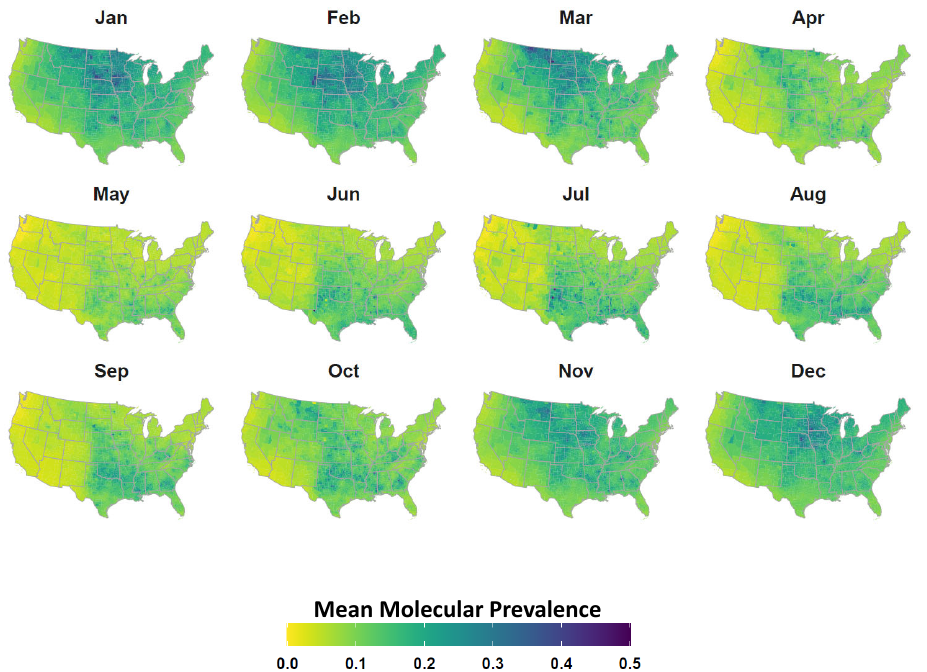
Figure A14. Dynamic avian WNV mean molecular prevalence. Molecular prevalence covariate under assumption of a dynamic species pool (monthly varying). Covariate reflects avian community average WNV prevalence based on estimates reported by Tolsá et al. [54]. Mapped counties are color coded according to legend at bottom to indicate increased WNV prevalence with darker tones.